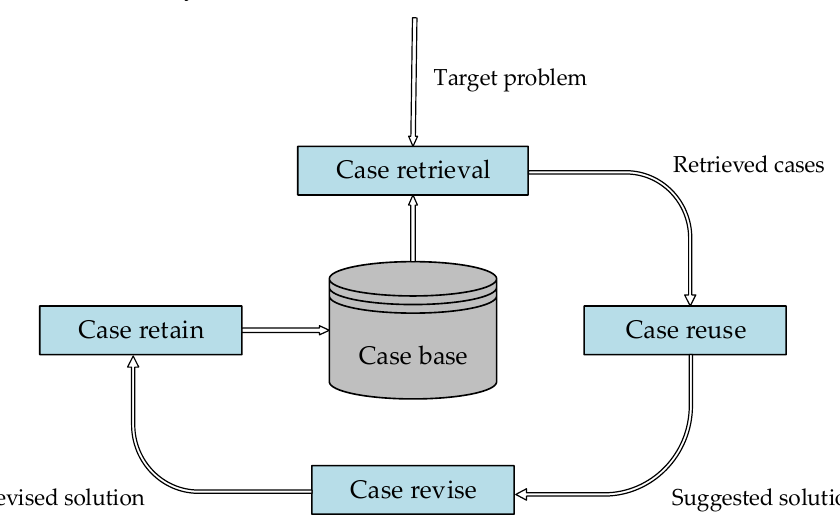
Figure 1. Basic framework of CBR.